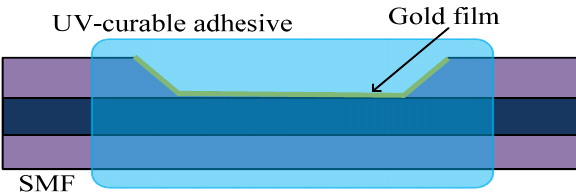
Figure 22. The SPR sensor consists of UV-curable adhesive and gold film [94].